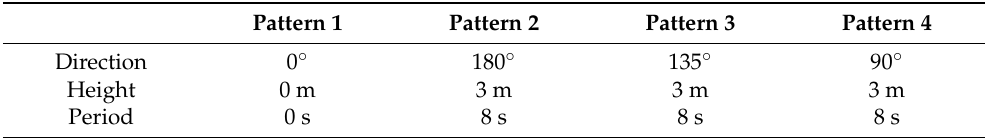
Table 3. Wave image